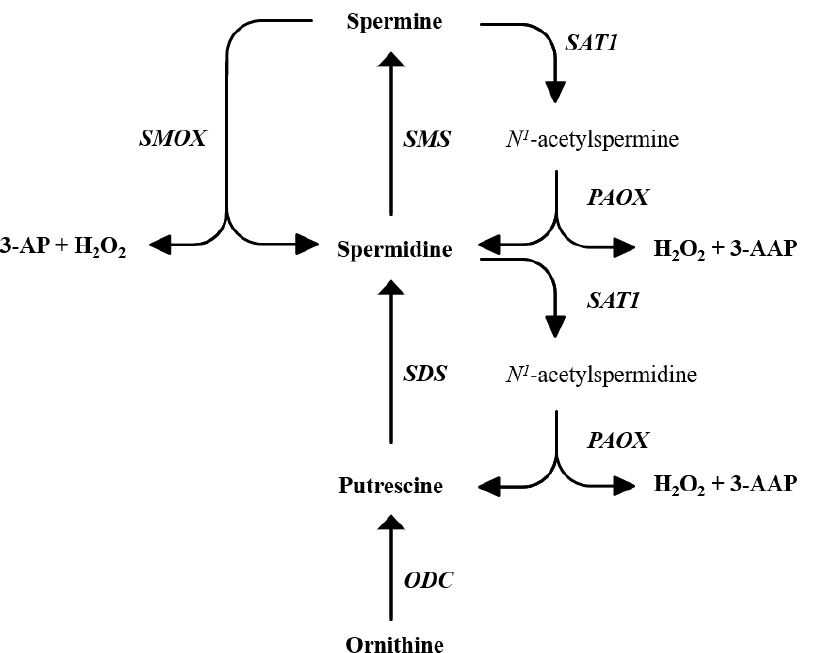
Figure 1. Schematic representation of polyamine metabolism showing enzyme networks and substrate interconversion pathways. PAOX: acetylpolyamine oxidase, ODC: ornithine decarboxylase, SMOX: spermine oxidase, SDS: spermidine synthase, SMS: spermine synthase, SAT1: spermine/spermidine N1 ‐ acetyl ‐ transferase, 3 ‐ AP: 3 ‐ aminopropanal, 3 ‐ AAP: 3 ‐ acetoamidopropanal.